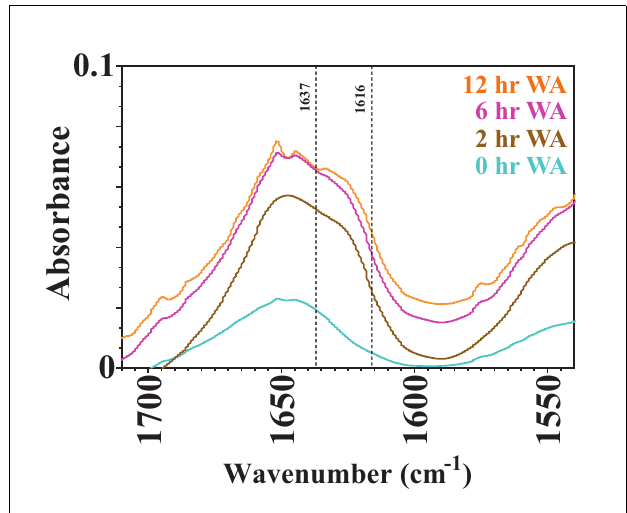
FIGURE 4 | FTIR absorbance spectra of 0, 2, 6, and 12 h water annealed silk sponges. The dotted lines at 1,616 and 1,637 cm - 1 define the region of wavenumbers over which increased absorbance indicates the presence of β -sheet structures.